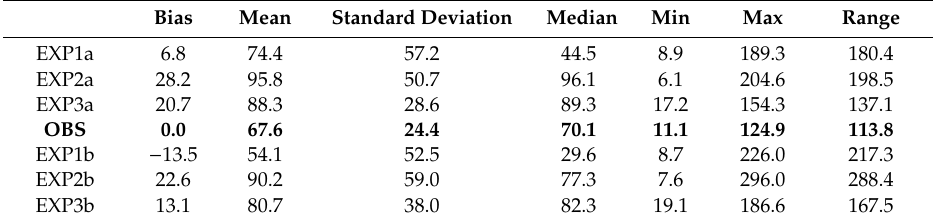
Table 8. Latent heat flux (LHF) (W m − 2 ) simulated and observed at the FB station (data number 268). Bias Mean